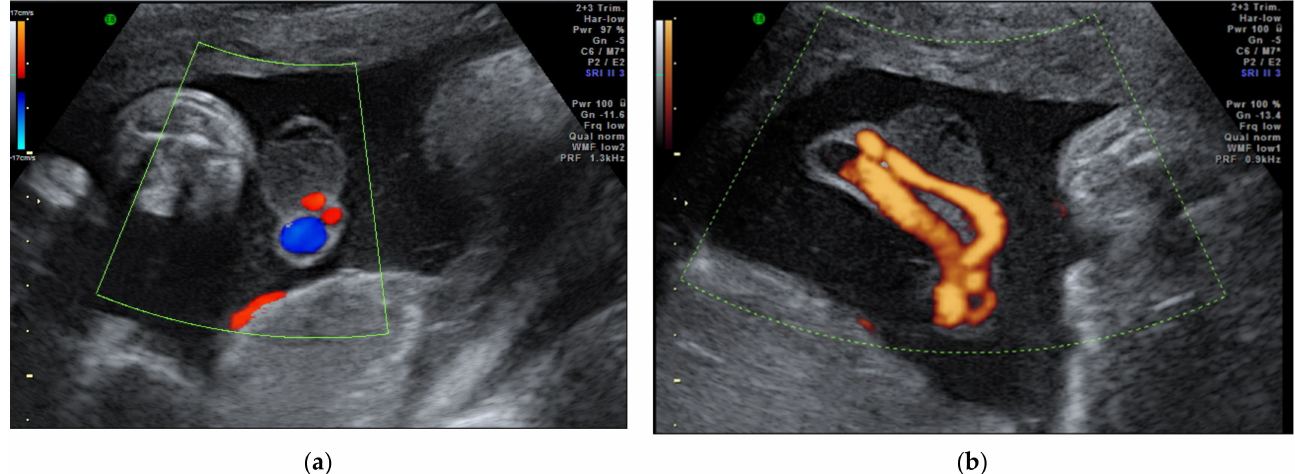
Figure 10. Cord hematoma seen on ( a ) 2D color Doppler imaging and ( b ) power Doppler